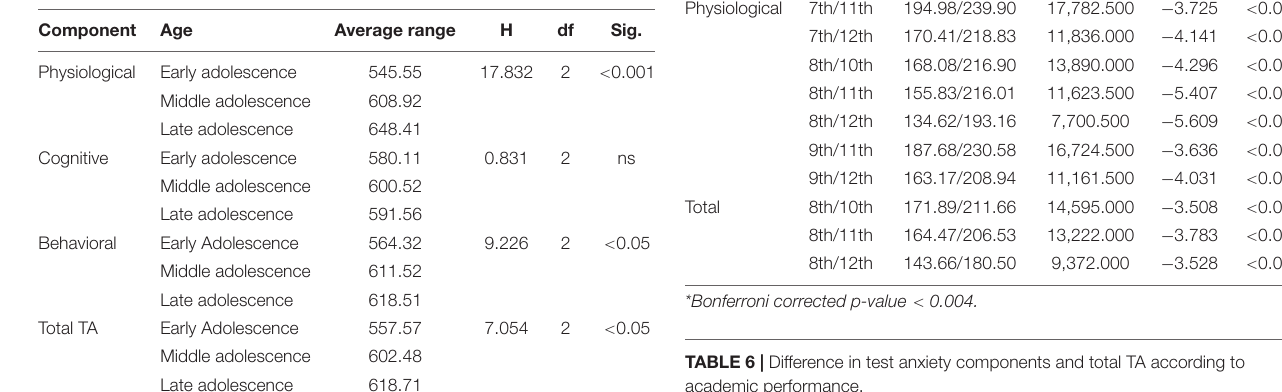
TABLE 3 | Age differences in test anxiety scores.